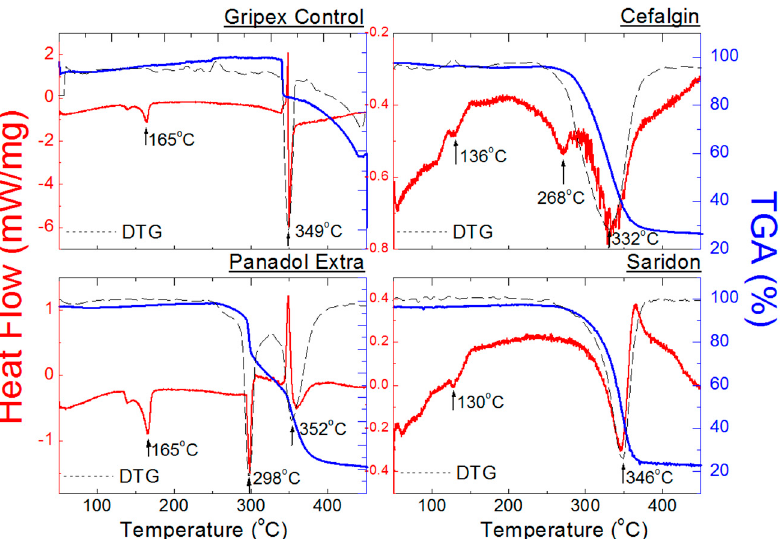
Figure 12. DSC and TGA/DTG curves of the drugs containing ACP and caffeine Gripex Control, Cefalgin, Panadol Extra, and Saridon.